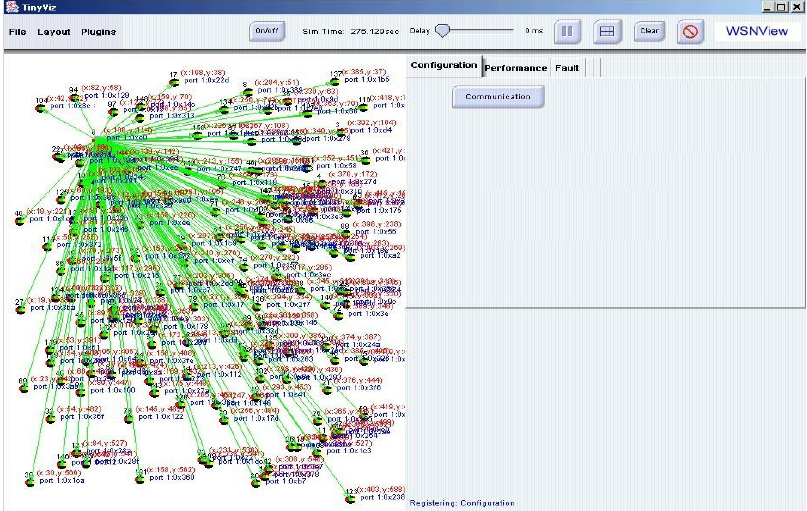
Figure 7. Configuration after Redeployment.